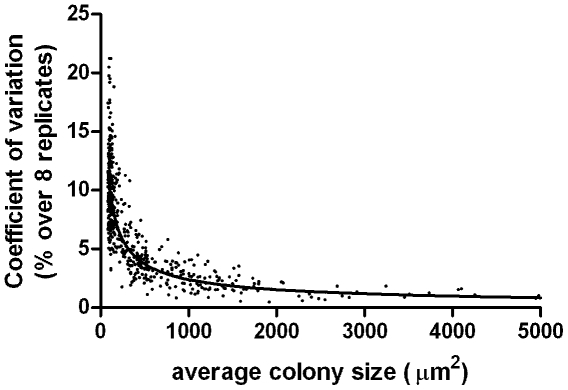
Coefficient of variation in object size vs. average object size over 8 separate measurements of approx.500 objects.